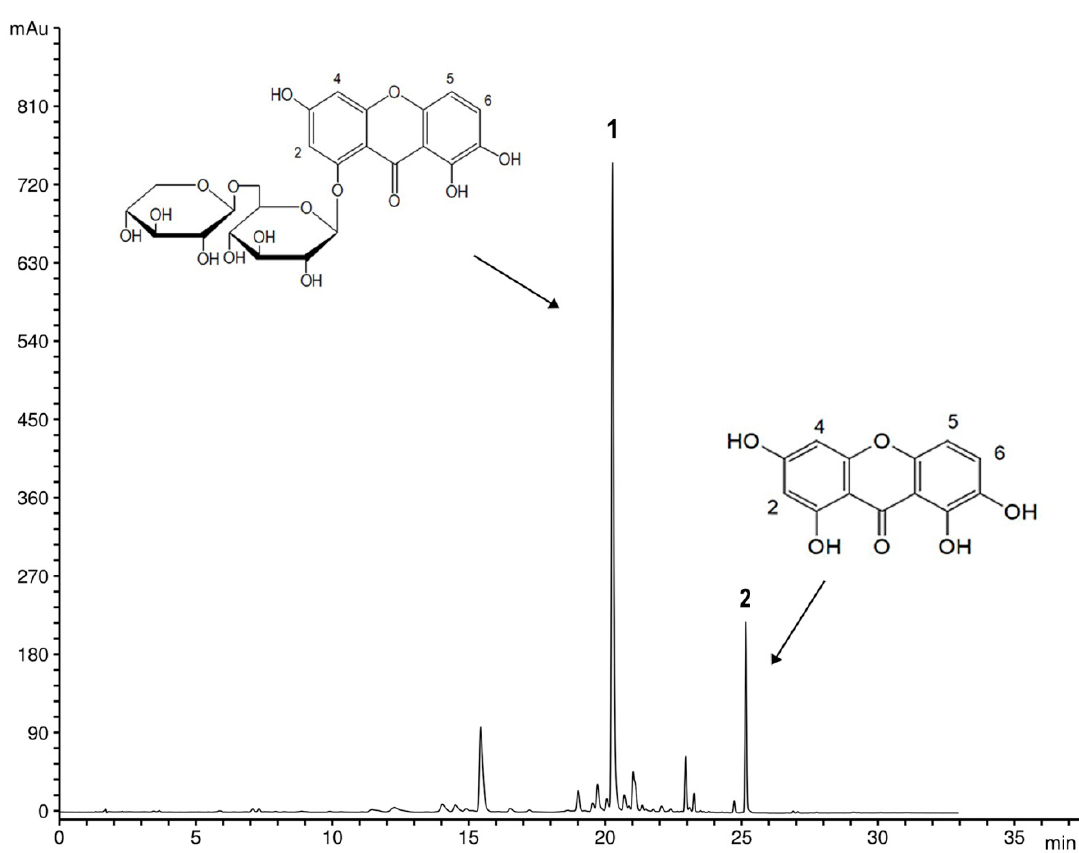
Figure 3. HPLC profile ( λ = 260 nm) typical for methanol extract of G. dinarica hairy root clones with chemical structures of the main xanthones norswertianin-1- O -primeveroside (peak 1) and norswertianin (peak 2).